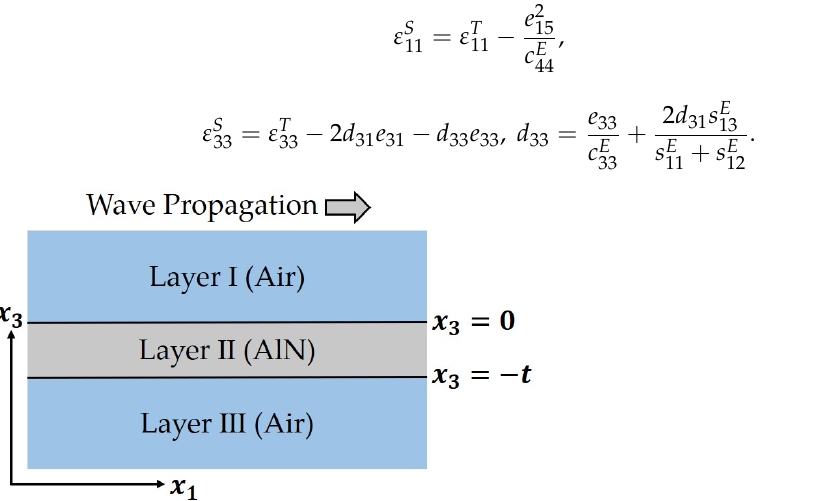
Figure 2. The 2D model of LWR extending infinitely in the x 1 direction, where the polarization direction of AlN is x 3 , and lamb wave propagates along the x 1 direction.